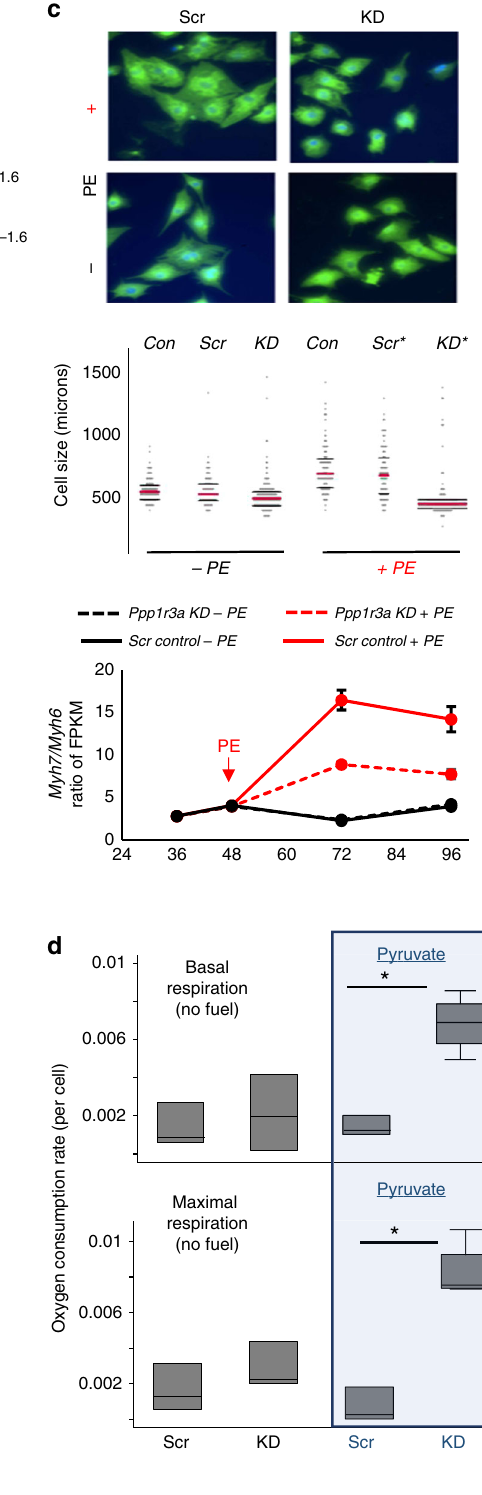
(Supplementary Fig. 7). Pyruvate dehydrogenase kinases